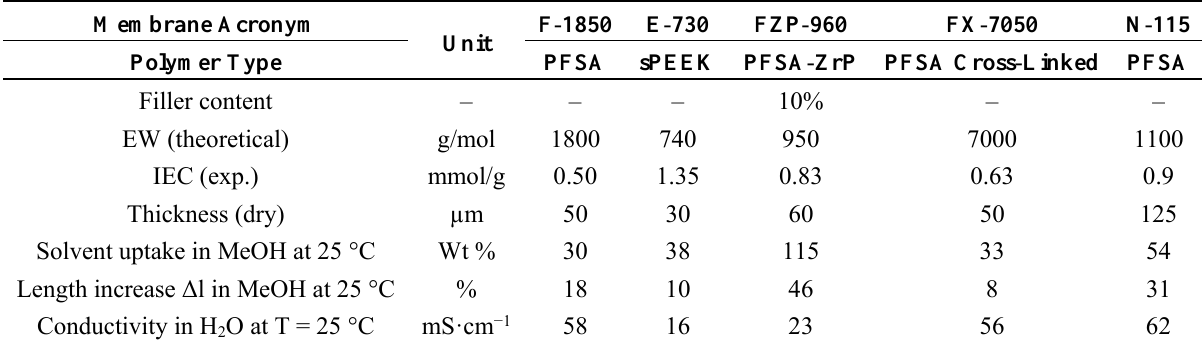
Table 1. Ex situ characterization data of the most promising Fumatech membranes for each category compared to Nafion ®